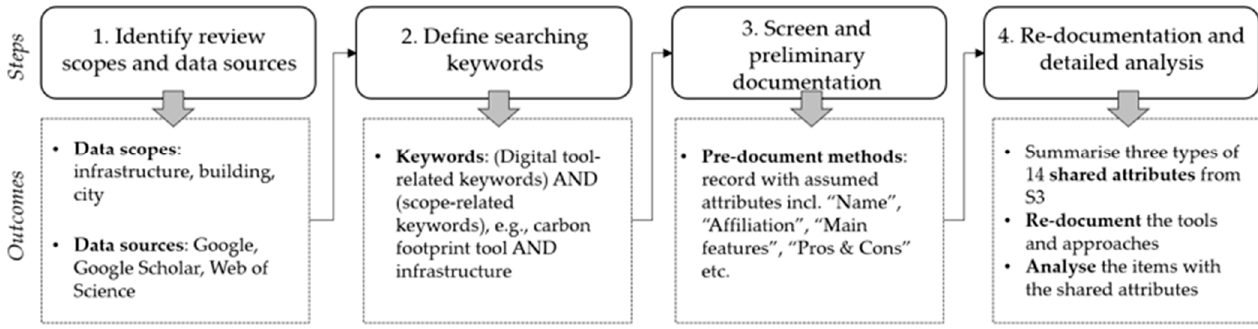
Figure 1. The four-step review methodology.